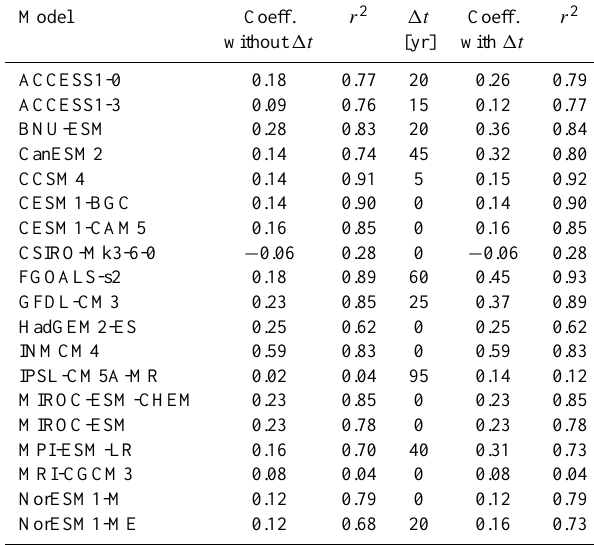
Table 6. Projections of ice discharge in 2100 according to Fig. 12. Numbers are in metres sea-level equivalent for the different global climate RCP scenarios with and without time delay 1t . The models PennState-3D, PISM and SICOPOLIS have an explicit representa- tion of ice-shelf dynamics and are denoted “shelf